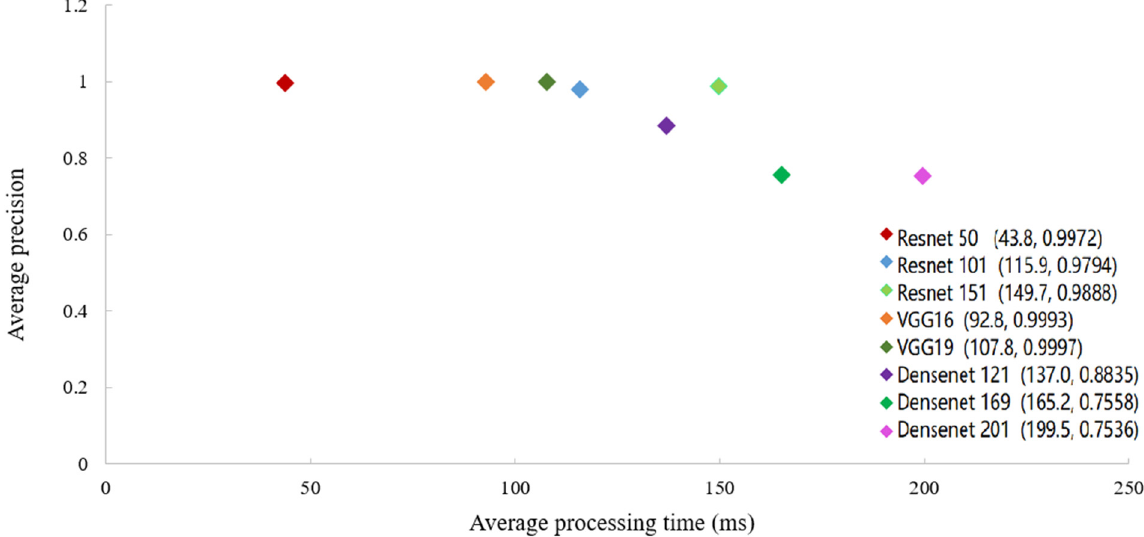
Figure 5. Average precision and average processing time of cattle face detection using different backbones. Table 1. Comparison of detection results with different backbones.